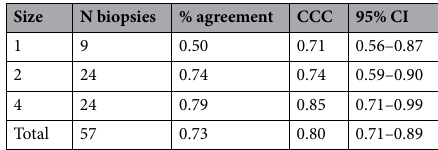
Table 4. Inter-rater agreement (CCC) for CD68 semi-quantitative score and according to size of biopsy forceps.